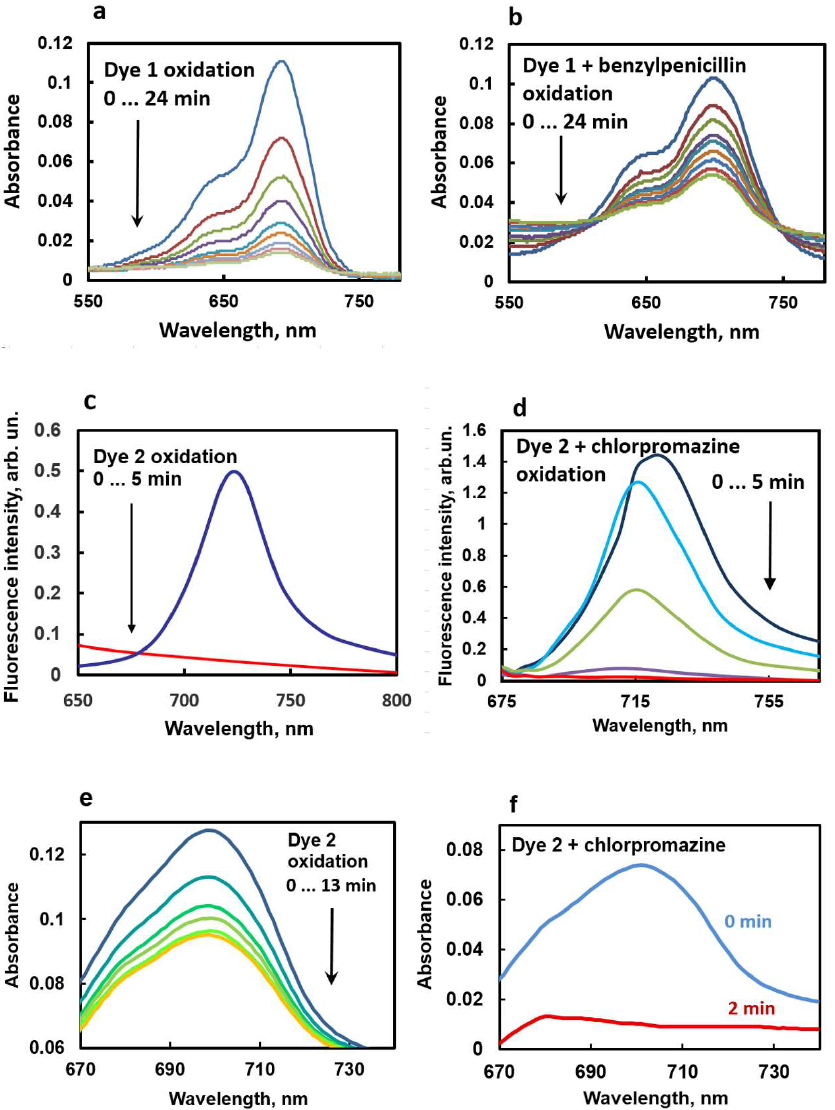
Figure 2. Effects of analytes in the oxidation of dyes with H 2 O 2 /Cu 2+ system: absorbance spectra of dye 1 and its oxidation products in the presence of benzylpenicillin ( a , b ); dye 2 oxidation in the presence of chlorpromazine as observed in NIR ( c , d ) and visible spectra ( e , f ). To avoid measuring full spectra and using full-scale spectral equipment, we obtained the photographic images of the 96-well plates using a NIR photo camera (for fluorescence) and a smartphone (for absorbance) with subsequent digitalization. Images of the plates with dye 2 and 4 are shown in Figures 4 and S5 as examples. From the viewpoint of dis- crimination tasks, it is important that the signals vary for different analytes. For example, the products of dye 2 oxidation are colored differently in the presence of different pheno- thiazines (Figure 4). Theoretically, all data received could be subjected to PCA treatment, but such an operation would be excessively laborious. For this reason, we only used the selected time points at which the model analytes yielded the most diverse responses (Ta- ble 1).